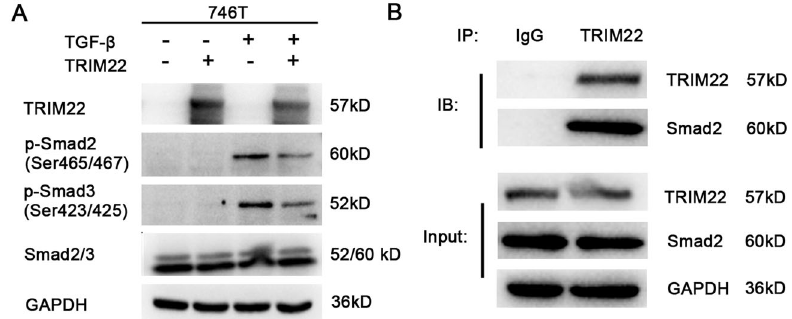
Fig. 4 Effect of TRIM22 on Smad protein expression. A Overexpression of TRIM22 inhibited TGF- β -induced phosphorylation of Smad2 and Smad3 (WB). B TRIM22 could direct binding to Smad2 (Co-IP). Data are shown as mean ± SD of three independent